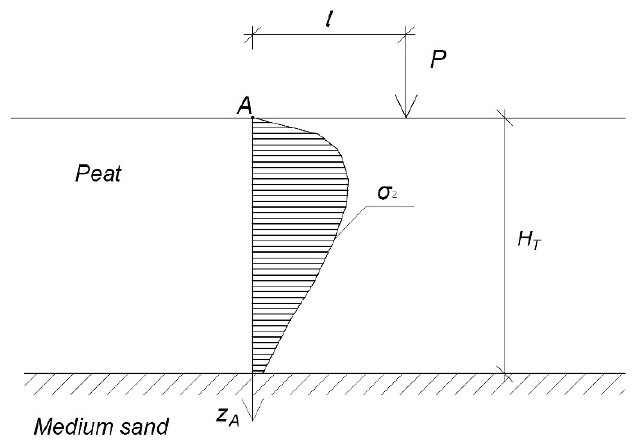
Figure 5. Stress distribution at distance l from the force P according to Boussinesq; A , analysed point ( − ); P , force (kN); l , distance from an analysed point to force (kN); H T –thickness of the organic soil (m); σ z , stress distribution in the soil (kPa); z A , axis of depth.